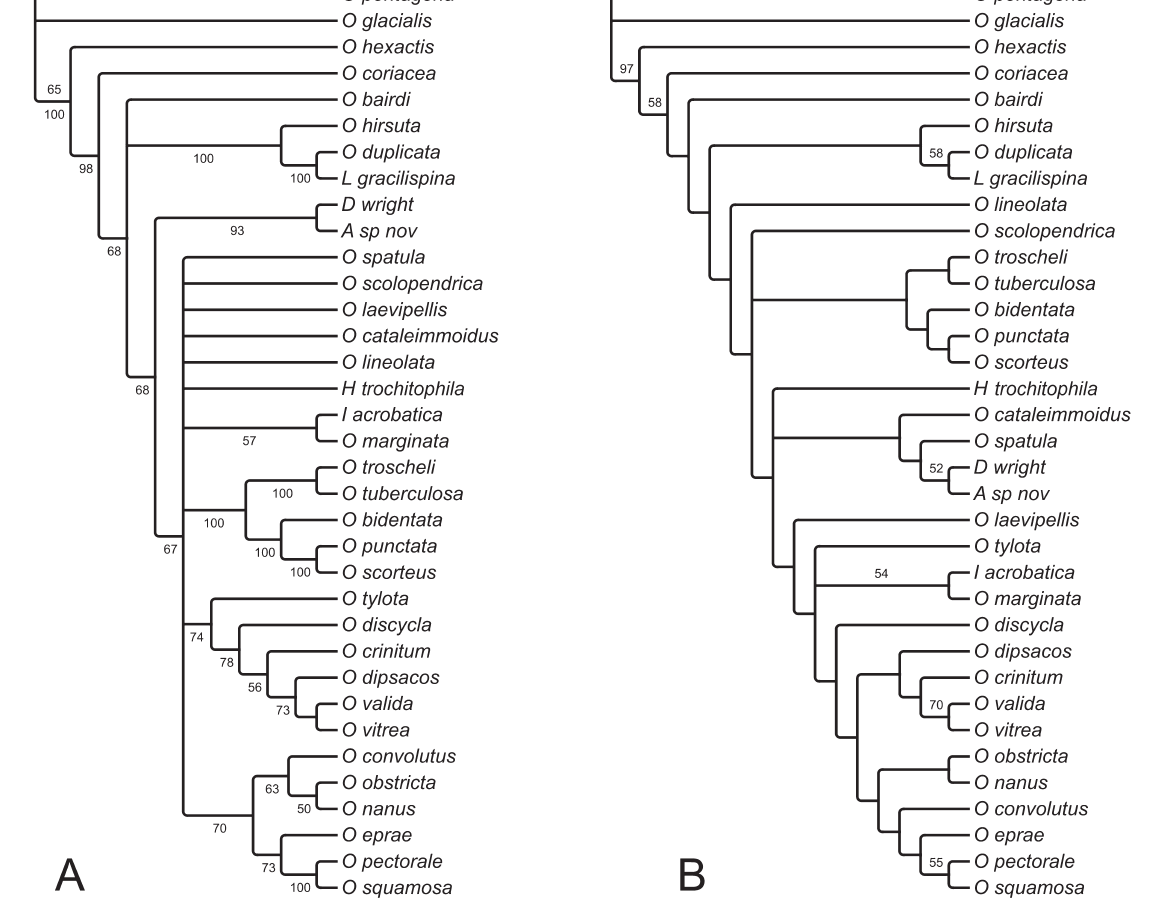
Fig. 2. Phylogeny of the Ophiacanthidae. A. Majority rule consensus of 2572 most parsimonious trees (182 steps length) resulting from the phylogenetic analysis of the full data set. B. Strict consensus of nine most parsimonious trees (47.91375 steps length) resulting from the analysis of the reweighed dataset (characters reweighed by their maximum rescaled consistency index). Numbers above branches represent bootstrap support for the respective nodes (10 000 replicates); numbers below branches are node frequencies of the majority rule consensus